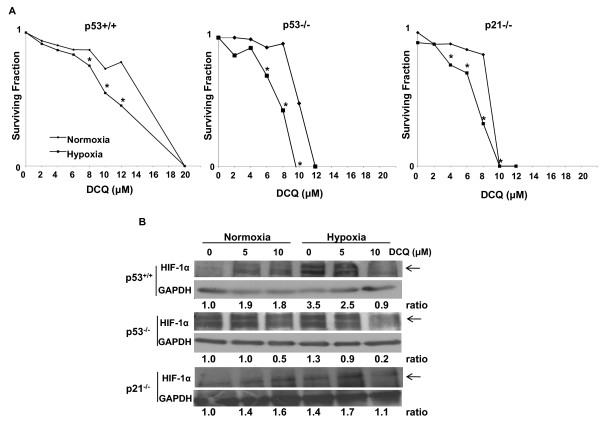
DCQ reduces the clonogenic survival of HCT116 cells more so under hypoxia than normoxia. (A) Clonogenic survival of DCQ-treated cells exposed to normoxic or hypoxic conditions. At 50% confluency, cells were treated for 12 hrs with different DCQ concentrations in normoxia or hypoxia, after which they were replated at low densities and colonies (more than 50 cells) were stained and counted after 10-14 days in culture. Surviving fractions were calculated as mentioned in "Methods". (*) indicates p < 0.05 (one way ANOVA). (B) Effect of DCQ on HIF-1α protein expression. Cells were plated in 100 mm dishes and treated for 6 hrs with DCQ while in normoxia or hypoxia. Whole cell lysates were immunoblotted for HIF-1α. GAPDH was used to ensure equal loading. Relative densitometry values are presented at the bottom of the blots. All ratios were normalized to GAPDH and calculated relative to the control cells cultured under oxia. The experiment was repeated three times each in triplicates.